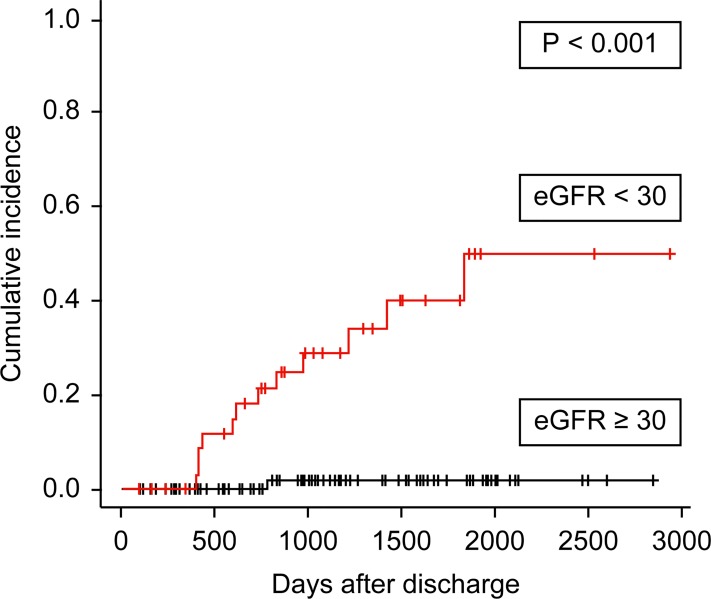
Cumulative incidences curves depicting period of time between discharge and chronic dialysis initiation censored for death.Association between estimated glomerular filtration rate (eGFR) ≥30 or <30 mL/min/1.73 m2 at hospital discharge and chronic dialysis initiation.